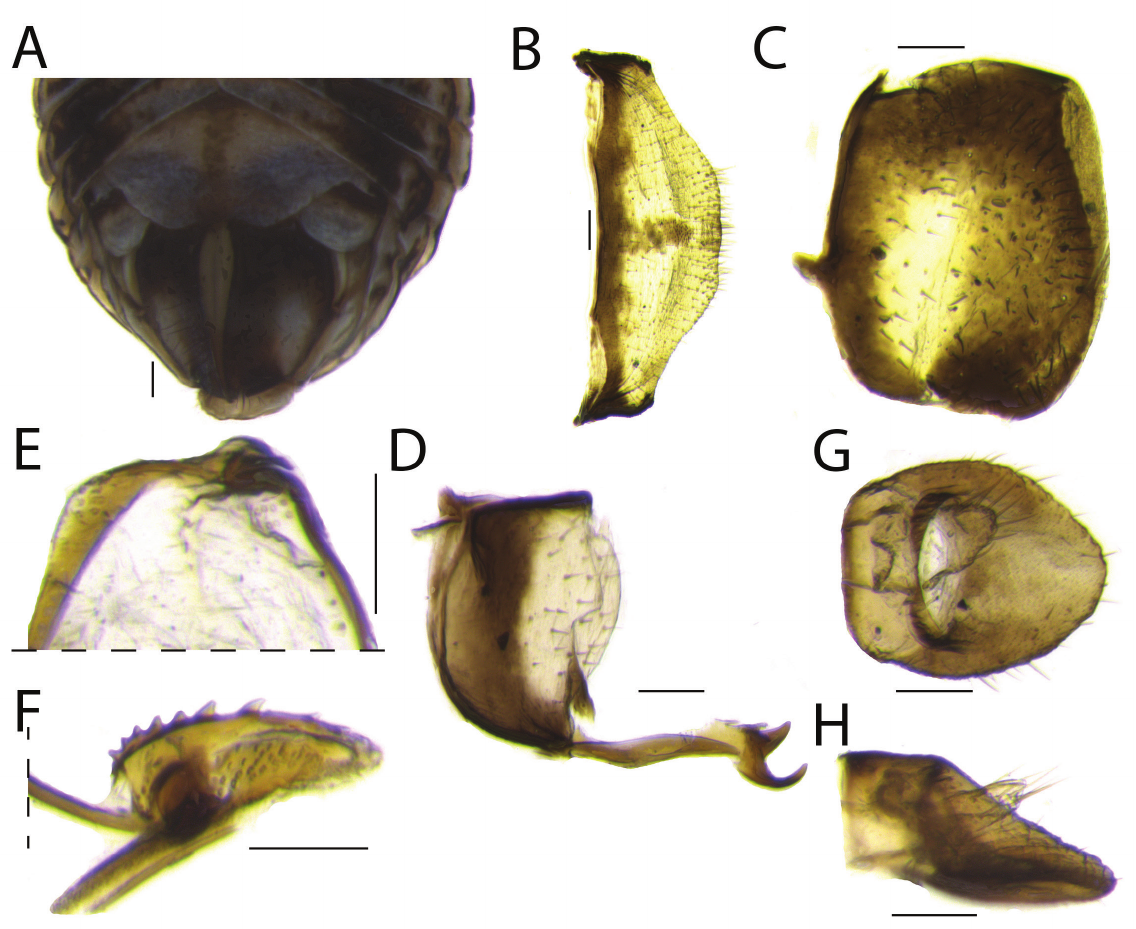
Fig. 15. Female terminalia of Fitchiella zahniseri sp. nov., paratype (INHS). A . External female terminalia, ventral view. B . Sternite VII, ventral view. C . Gonoplac, lateral view. D . Anterior connective lamina of gonapophysis VIII, ventral view. E–F . Posterior connective lamina of gonapophysis IX. E . Connective part in dorsal view. F . Distal part in lateral view. G–H . Anal tube. G . Dorsal view. H . Lateral view. Scale bars = 0.1